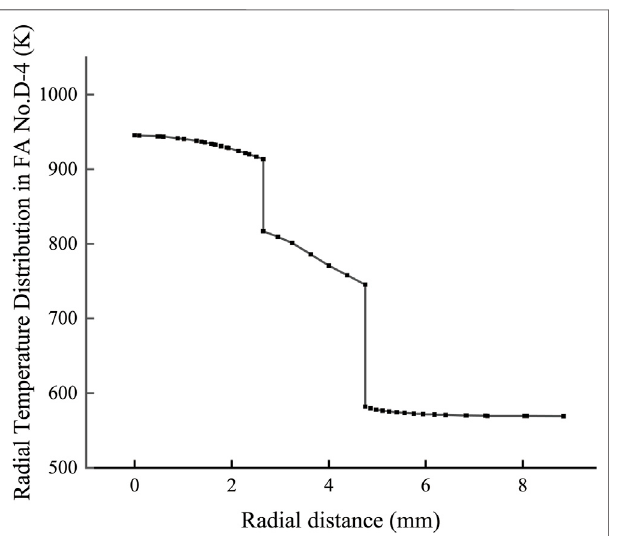
FIGURE 11 | Radial temperature distribution of D-4 assembly (z = 1 m).